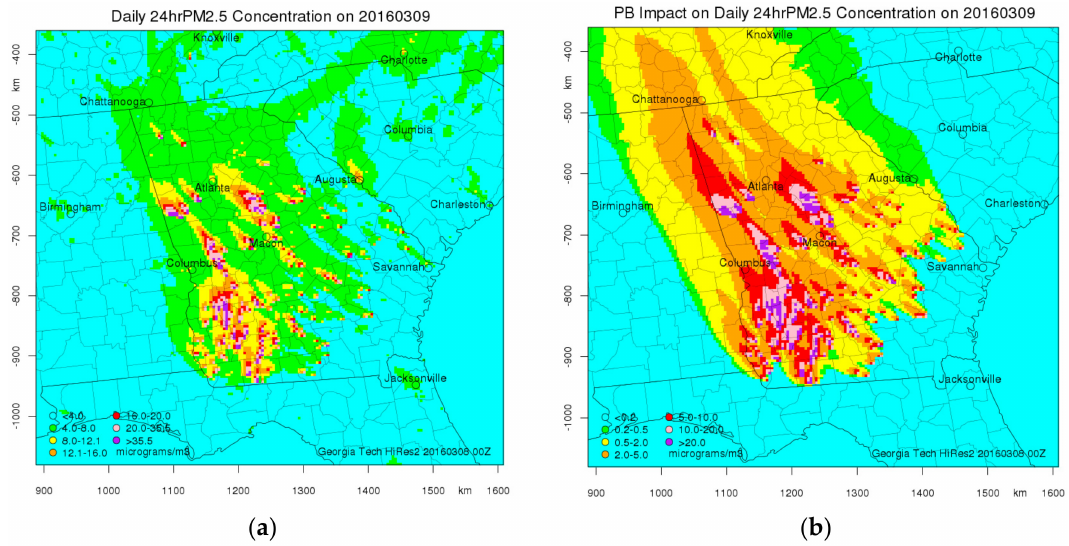
Figure 1. Illustration of HiRes2 daily forecast products: ( a ) 24-h average PM 2.5 (particulate matter with an aerodynamic diameter smaller than 2.5 µ m) concentrations ( µ g m − 3 ) on 9 March 2016 and; ( b ) on a different scale, the portion of PM 2.5 associated with prescribed burns in Georgia